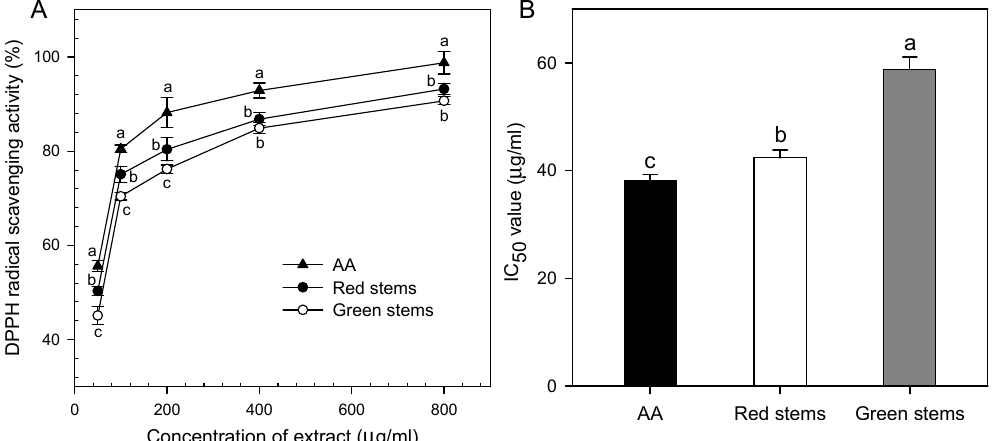
Figure 1. DPPH radical scavenging activity of extract from red and green D. officinale stems. ( A ) DPPH radical scavenging activity of AA, green and red stems extracts; ( B ) IC 50 value of extract from red and green D. officinale stems. AA: ascorbic acid; DPPH: 2, 2-diphenyl-1-picryhydrazyl. Each data bar represents the mean ± standard deviation (SD; n = 3). Different letters above bars indicate significant differences among different treatments at p < 0.05 based on student’s t -test. Both red and green stems exhibit a significantly lower IC 50 value according to a student’s t -test ( p < 0.05) when compared with AA, and red stems demonstrate better antioxidant activities than green stems.